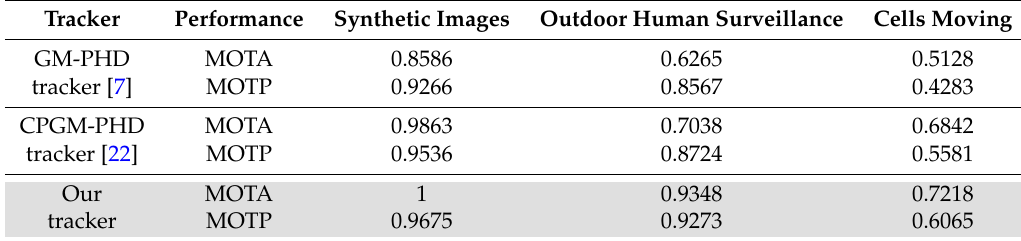
Table 1. Tracking performance comparison of the GM-PHD tracker, CPGM-PHD tracker and our tracker. MOTA, multi-object tracking accuracy; MOTP, multi-object tracking precision.